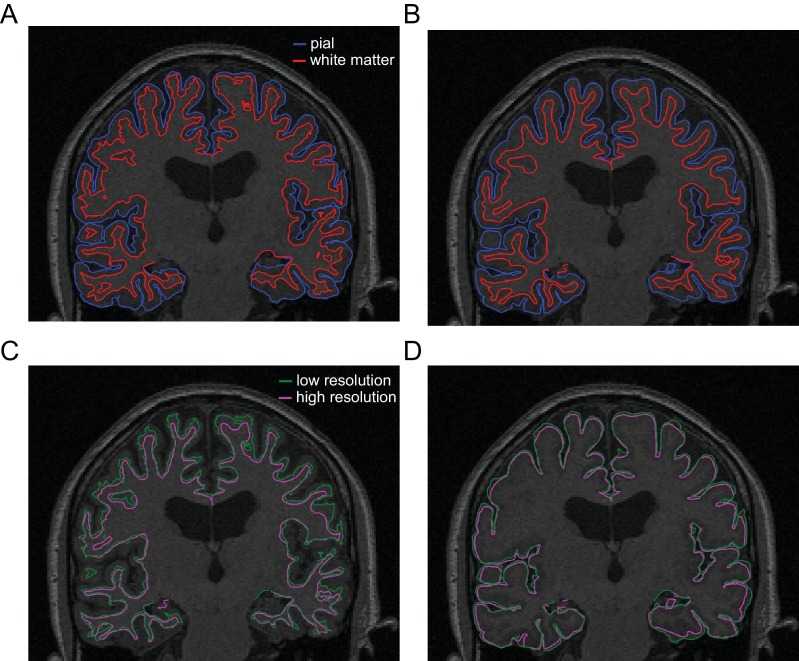
FreeSurfer-extracted surfaces.(A) Pial (blue) and white matter (red) surfaces extracted from a standard T1-weighted MRI. (B) Pial and white matter surfaces extracted from the multi-parameter mapping (MPM) sequence used in the present study. (C) Comparison of white matter surfaces extracted from the standard T1-weighted MRI (green) and the MPM scans (magenta). (D) Comparison of pial surfaces extracted from the standard MRI and MPMs.